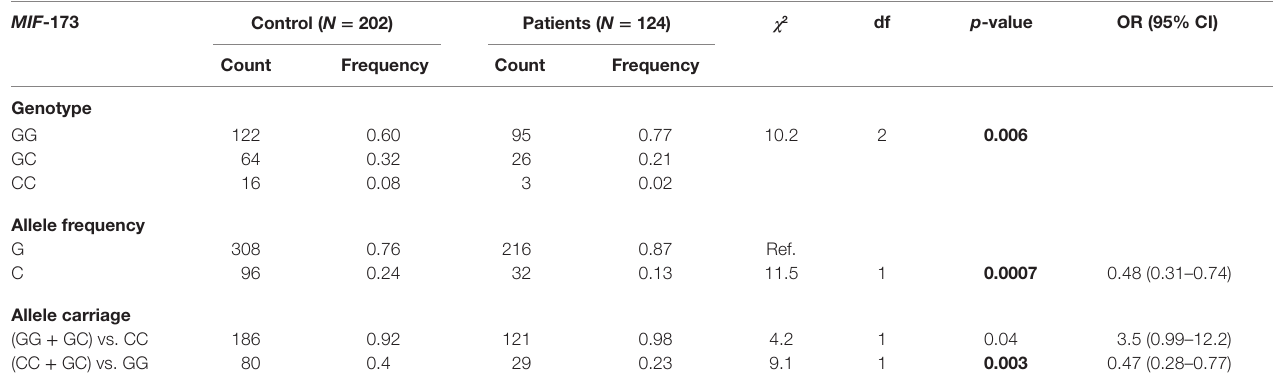
TaBle 2 | Distribution of MIF -173 polymorphism genotypes and allele frequencies in patients and controls. MIF -173